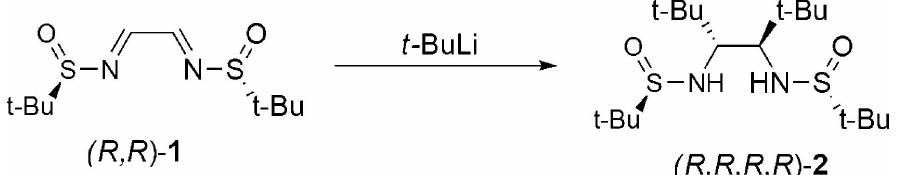
Figure 2 Synthesis of the title compound.